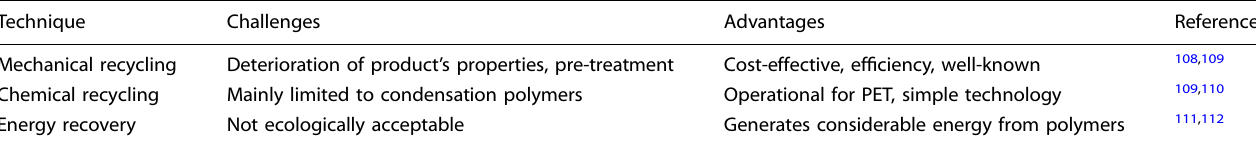
Table 2. Advantages and challenges of the recycling